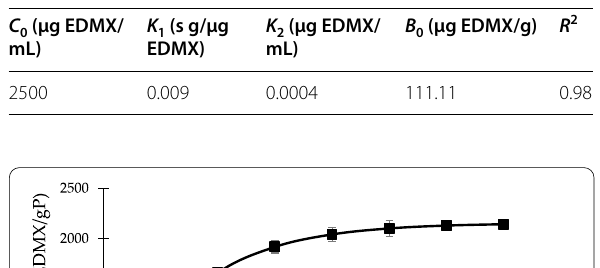
Table 2 Peleg model of microwave-assisted extraction of